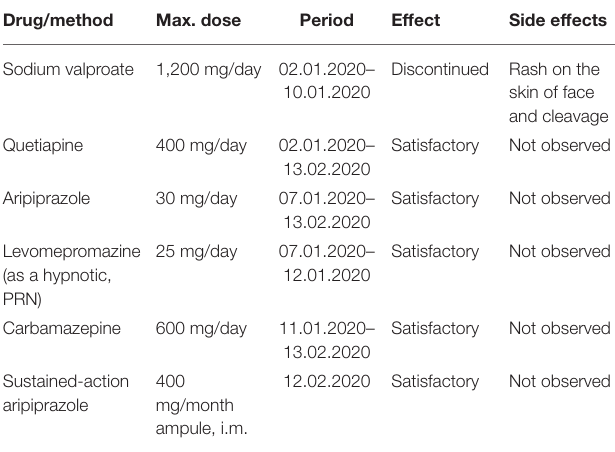
TABLE 1 | Serological examinations. Antibody Titer